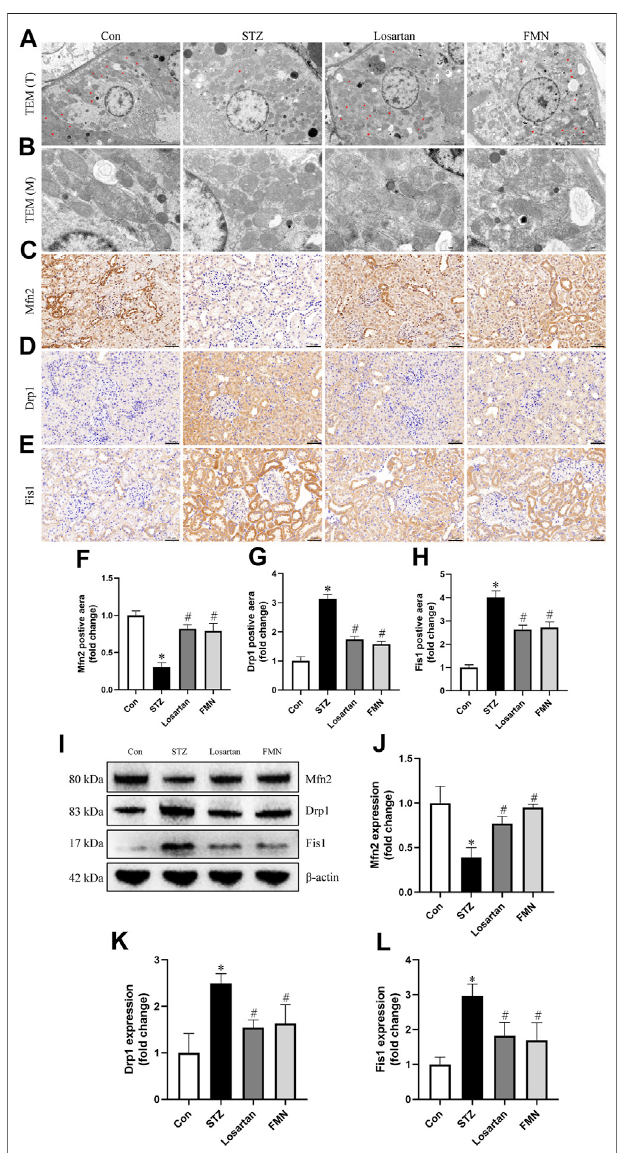
FIGURE 4 | FMN ameliorated the mitochondrial morphology abnormalities in renal tubular cells and restored the expression of dynamics- associated proteins in diabetic rats. (A) Mitochondria morphology alterations in renal tubular cells observed by TEM (original magni fi cation × 2,500, bars = 5 µm). T, tubules. Red asterisks, elongated cylindrical mitochondria. (B) High-magni fi cation TEM micrographs of mitochondrial ultrastructure (original magni fi cation × 8,000, bars = 1 µm). M, mitochondria. (C – E) Representative photographs of immunohistochemistry staining of Drp1, Fis1 and Mfn2 (original magni fi cation ×200, bars = 50 µm). And semiquantitative analyses of immunohistochemistry of Mfn2 (F) , Drp1 (G) and Fis1 (H) . (I – L) Representative Western blot images of Mfn2, Drp1 and Fis1 protein expression and semiquantitative analyses. Results were showed as mean